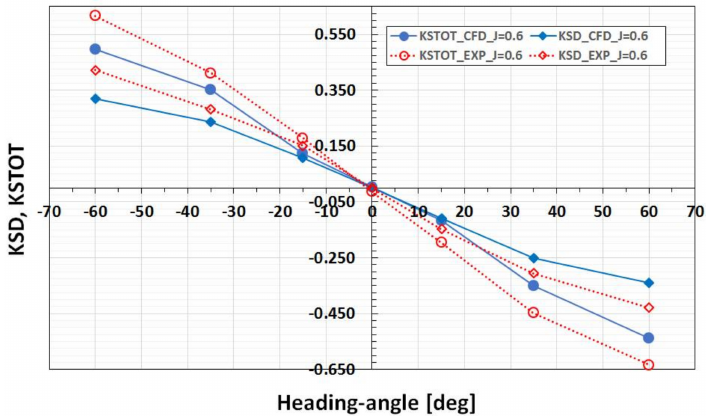
Figure 9. Measured (red) and computed (blue) duct side force, KSD, and total unit side force, KSTOT, at different heading angles and loading condition of J = 0.6.